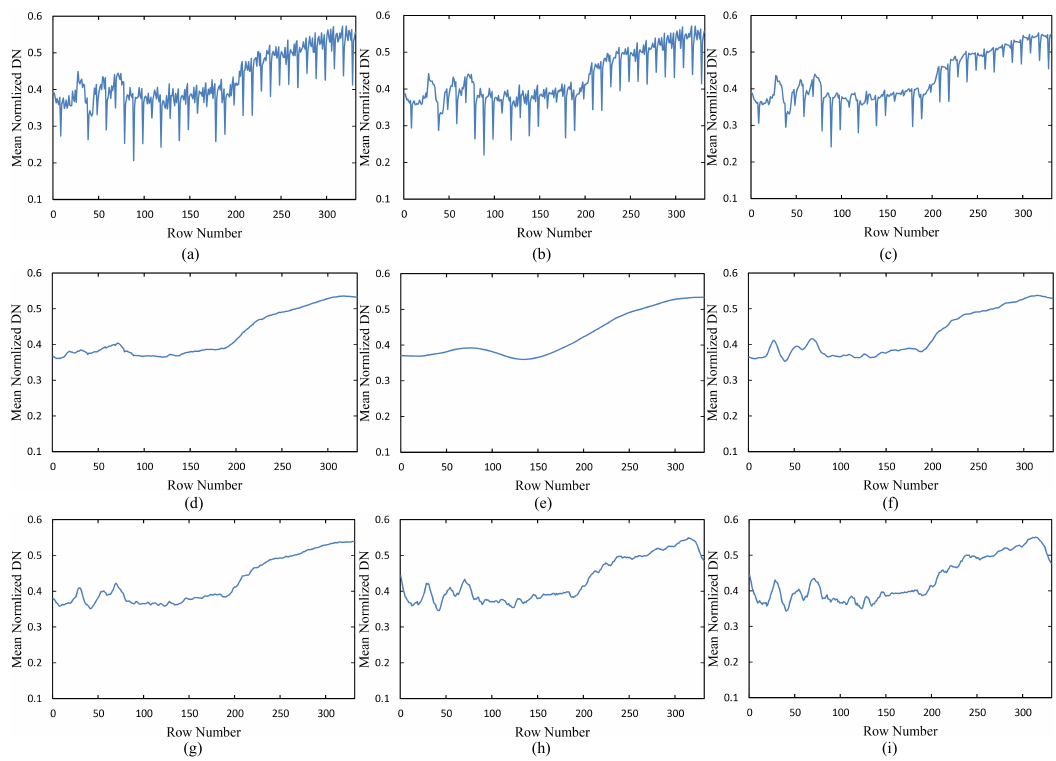
Figure 24. Mean cross-track profiles of Terra MODIS data R3. ( a ) original; ( b ) BM3D; ( c ) SNRCNN;